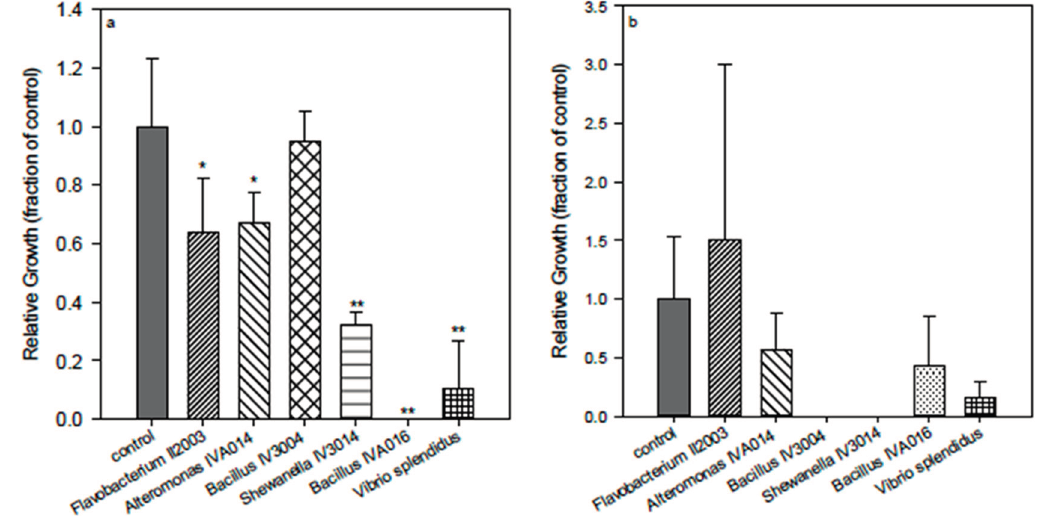
Figure 6. Comparison of basic activity of acrylate (1) surfaces using different marine bacteria: Flavobacterium II2003, Alteromonas IVA014, Bacillus IV3004, Shewanella IV3014, Bacillus IVA016, Vibrio splendidus . ( a ) = bacteria suspended in the supernatant media; ( b ) = bacteria attached to the control (polystyrene) or polymer surface. * ,